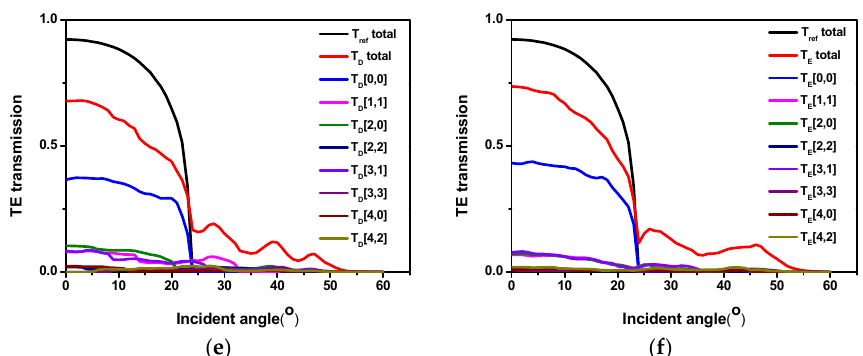
Figure 4. ( a ) Simulated relationships between the transmission and incident angle at a wavelength of 453 nm for LEDs with and without ITO periodic nanopillar arrays. The transmission of the total and each diffraction order as a function of the incident angle for nanopillars with different lattice constants: ( b ) 600 nm, ( c ) 800 nm, ( d ) 1050 nm, ( e ) 1200 nm, and ( f ) 1600 nm.